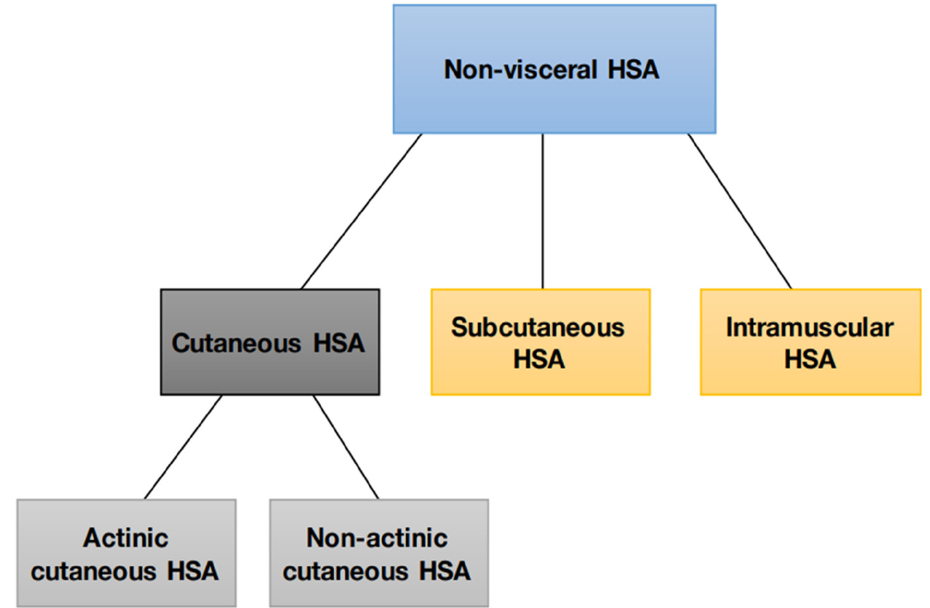
Figure 2. Most reported non-visceral HSA subtypes in dogs.